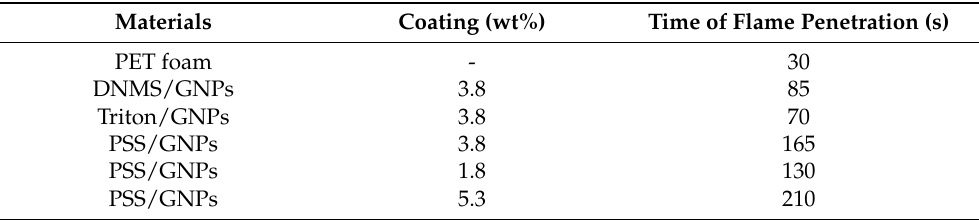
Table 2. Flame penetration times for PET foam and coated samples with both faces treated.